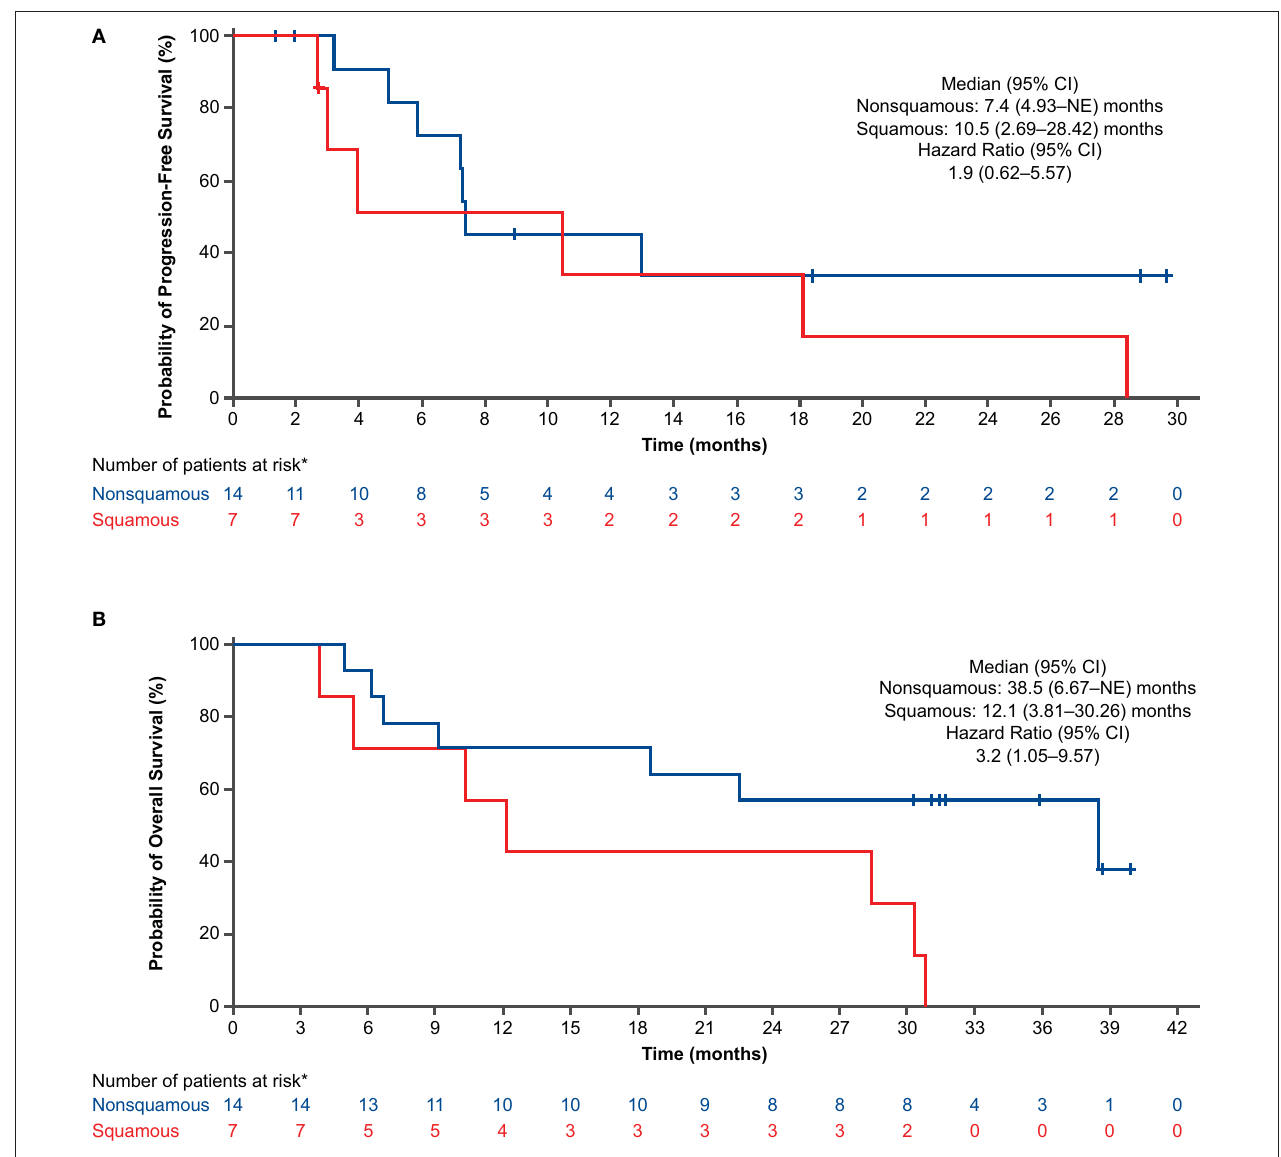
FIGURE 4 | Progression-free survival (A) and overall survival (B) by histology in all treated patients (concurrent cohort; dose-finding and expansion parts). *Histology was not confirmed for 1 patient. CI, confidence interval; NE, not evaluable.